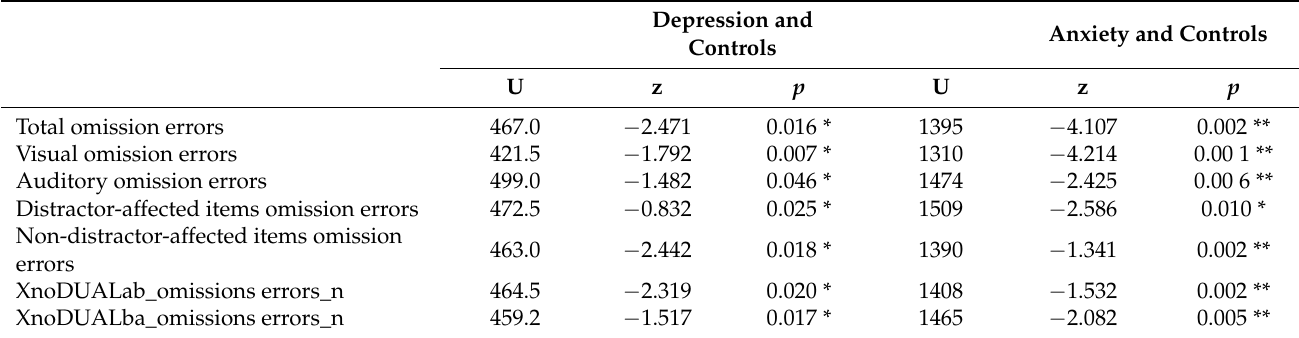
Table 3. Contrast of means between groups with depression and anxiety and controls. Attentional arousal. Depression and